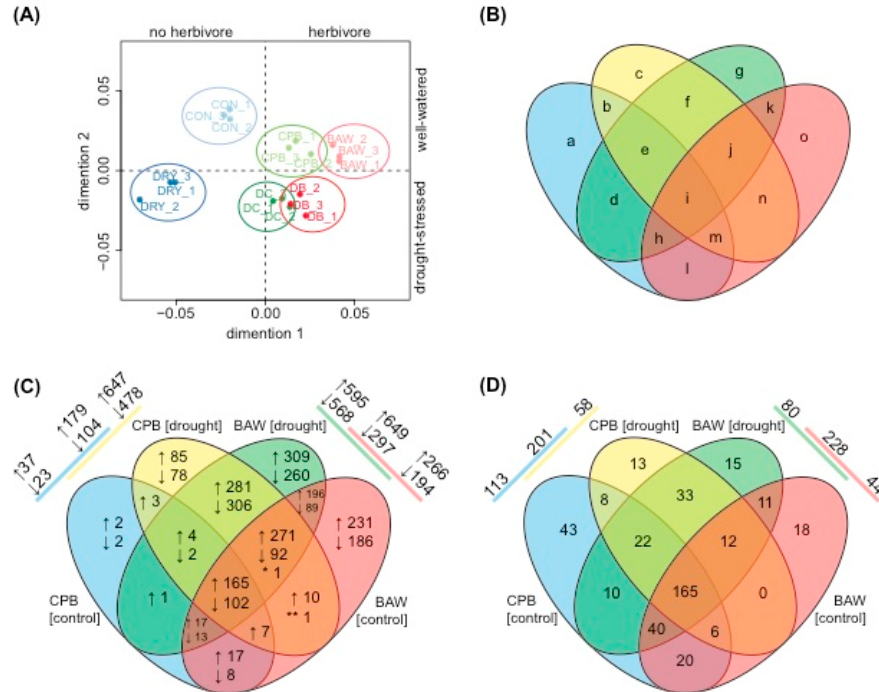
Figure 4. Transcriptomic regulation of Solanum dulcamara under combinations of watering and insect herbivory treatments. ( A ) Multidimensional scaling analysis of microarray data of plants under well-watering conditions without (CON) or with herbivory by Spodoptera exigua (BAW) or Leptinotarsa decemlineata (CPB), or of plants subjected to a moderate drought treatment without (DRY) or with herbivory by BAW (DB) or CPB (DC). Replicates of the same treatments are similarly colour-coded and circled. ( B ) Simplified scheme to clarify parts of Venn diagrams in ( C , D ). ( C ) Numbers of upregulated ( ↑ ) or downregulated ( ↓ ) genes of plants subjected to herbivory by S. exigua or L. decemlineata compared to undamaged plants under well-watering conditions (BAW [control] and CPB [control], respectively) or drought treatment (BAW [drought] and CPB [drought], respectively). * ↑ in BAW, ↓ in BAW [drought], and CPB [drought]; ** ↑ in BAW, ↓ in CPB [drought]. ( D ) Numbers of induced biological processes (BPs; both upregulated and downregulated) of plants under the same treatments. In the top left and right corners of Venn diagrams in ( C , D ) are the total numbers of specific or shared genes or BPs, respectively, induced by each insect on well-watered or drought-treated